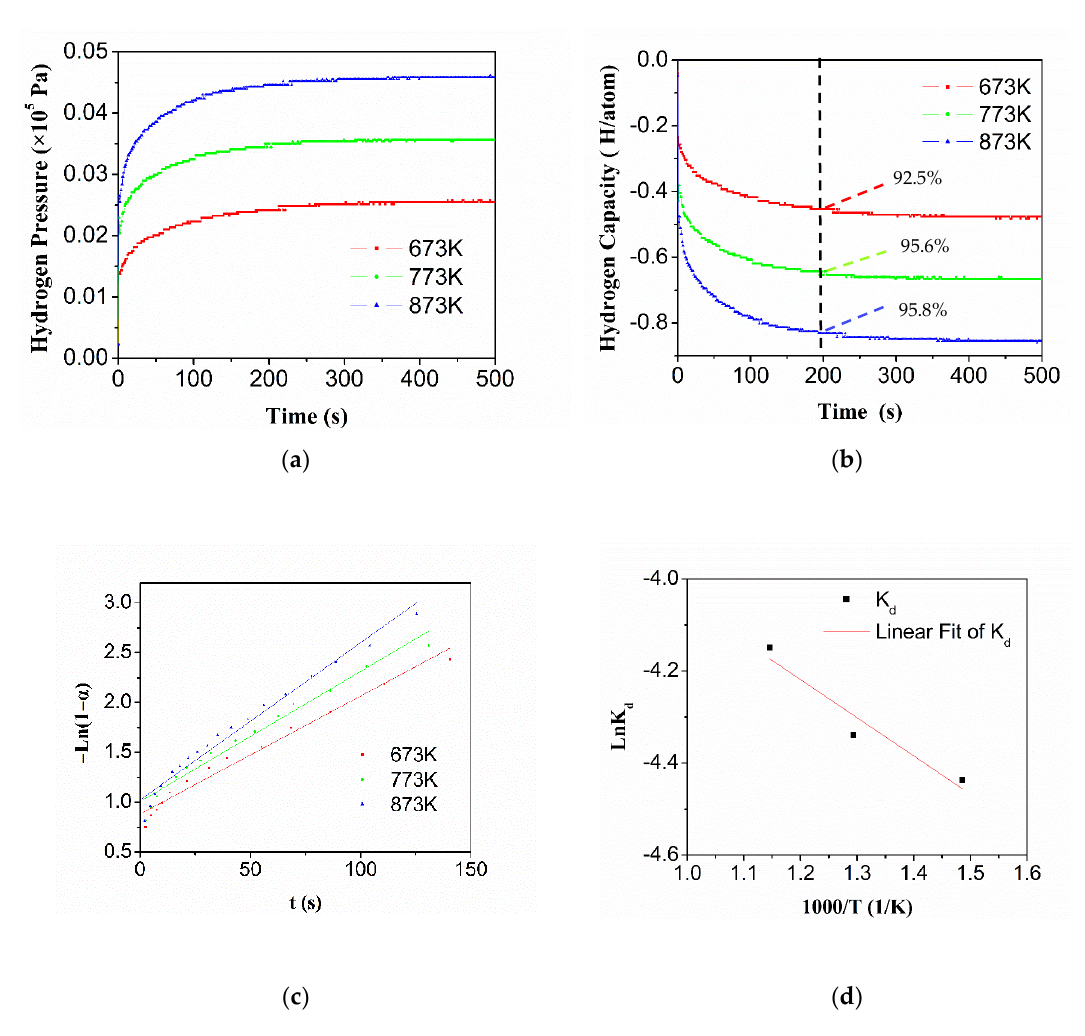
Figure 6. The hydrogen desorption kinetics curves of Ti 0.20 Zr 0.20 Hf 0.20 Nb 0.40 HEA at temperatures of 673 K, 773 K and 873 K: ( a ) hydrogen capacity; ( b ) hydrogen pressure; ( c ) the hydrogen desorption kinetic analysis curves of Ti 0.20 Zr 0.20 Hf 0.20 Nb 0.40 HEA; ( d ) the relationship between activation energy and temperature of the hydrogen desorption reaction. Table 4. The hydrogen desorption equilibrium pressure, equilibrium hydrogen storage capacity